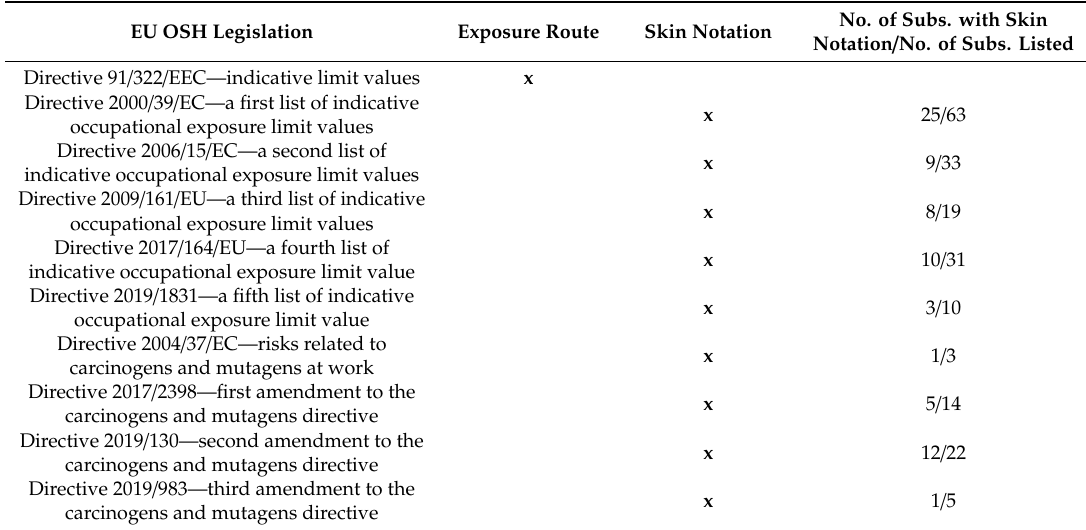
Table 2. List of European Union (EU) occupational safety and health (OSH) legislation that mentions skin notation. Exposure Route Skin